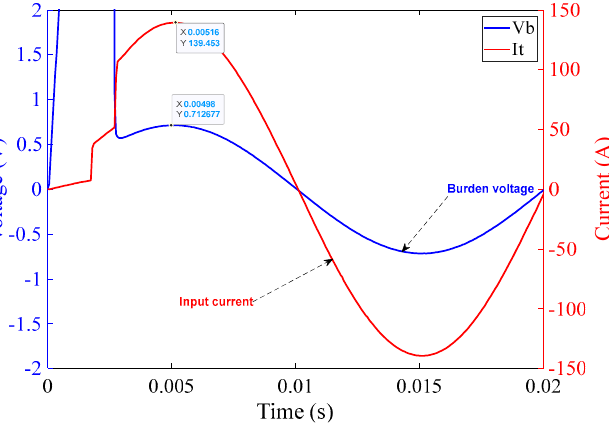
Figure 22. Burden voltage across 1 Ω burden circuit at 100 A(rms) input current.